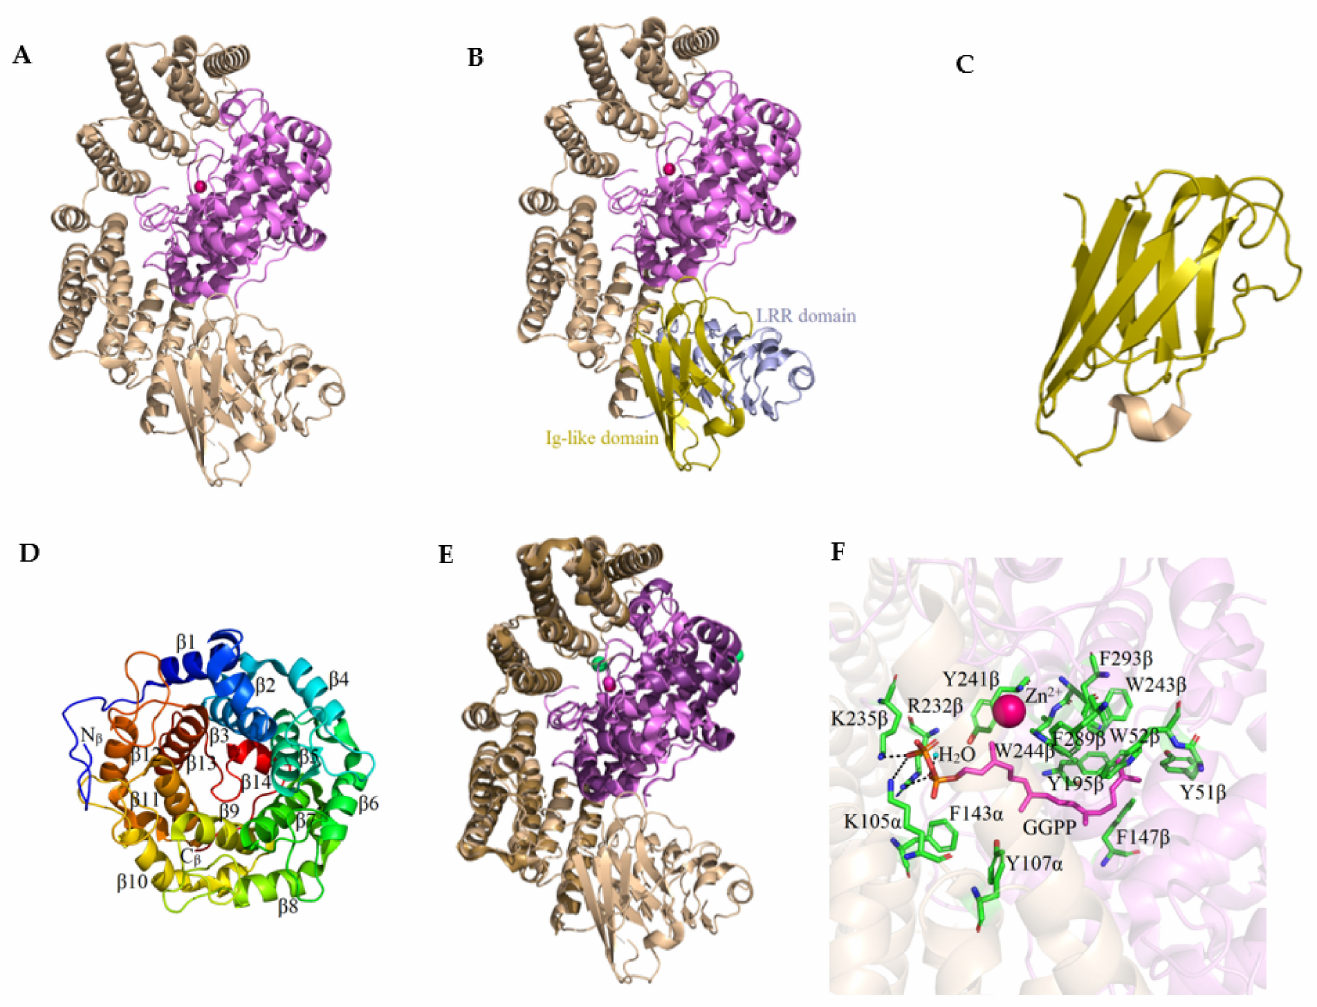
Figure 5. Overall structures of Rab geranylgeranyltransferase, with the α subunit shown in beige and β subunit in pink ( A ) (PDB: 1DCE). Representation of the RGGT structure, with three domains of the α subunit shown in different colors (beige, the α -helical domain; yellow, the Ig-like domain; blue, the LRR domain containing leucine-rich repeats) ( B ). The labeled strands of the Ig-like domain ( C ). The β subunit of RabGGT, and the helices numbered β 1– β 14 and in different colors ( D ). Superposition of 1DCE (beige, α subunit; pink, β subunit) and 3DSS (brown, α subunit; violet, β subunit) ( E ). The crystal structure of RGGT in complex with geranylgeranyl pyrophosphate ( F ) (PDB: 3DST). The zinc ion is shown in red. (Created in the PyMOL Molecular Graphics System, Version 2.5.2 Schrödinger,